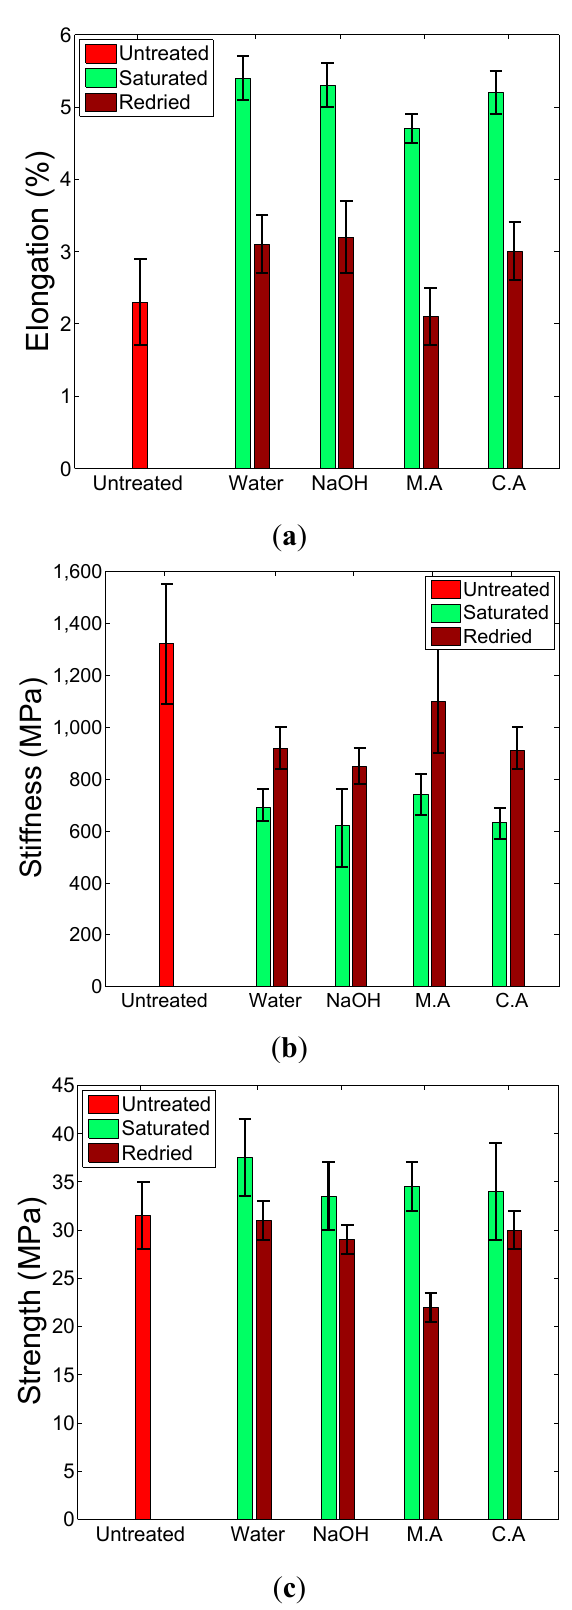
Figure 4. Tensile property data for CNFC samples under various aqueous treatments showing ( a ) elongation; ( b ) stiffness and ( c )